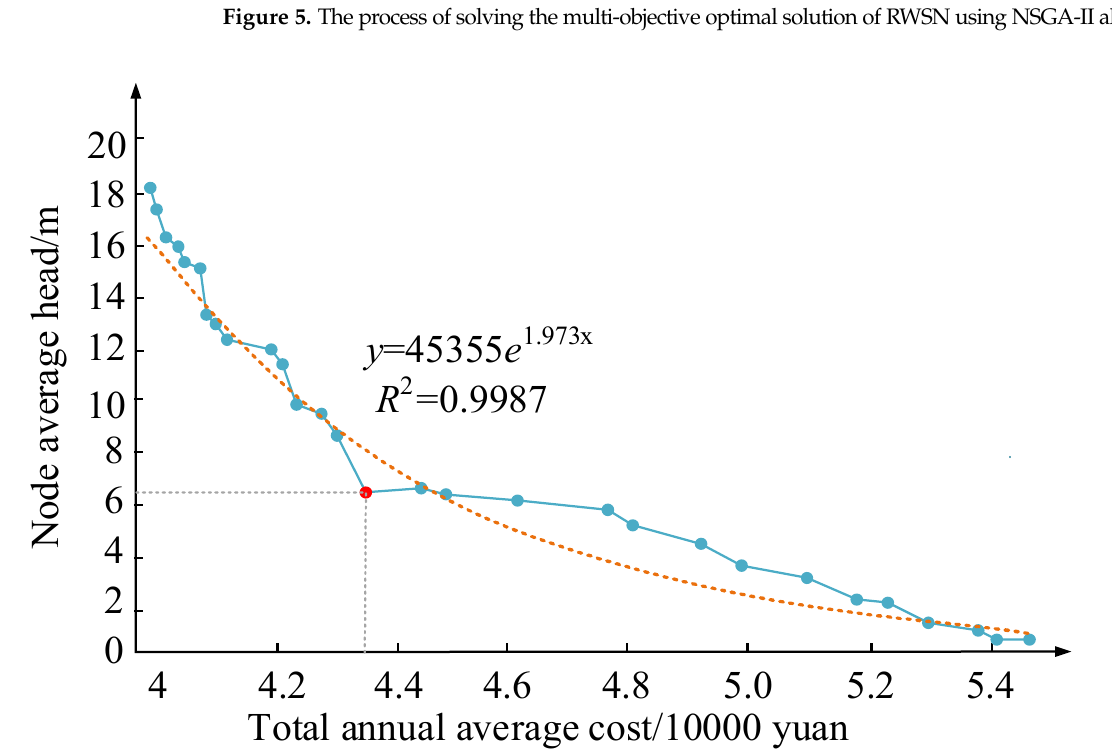
Figure 5. The process of solving the multi-objective optimal solution of RWSN using NSGA-II algorithm.